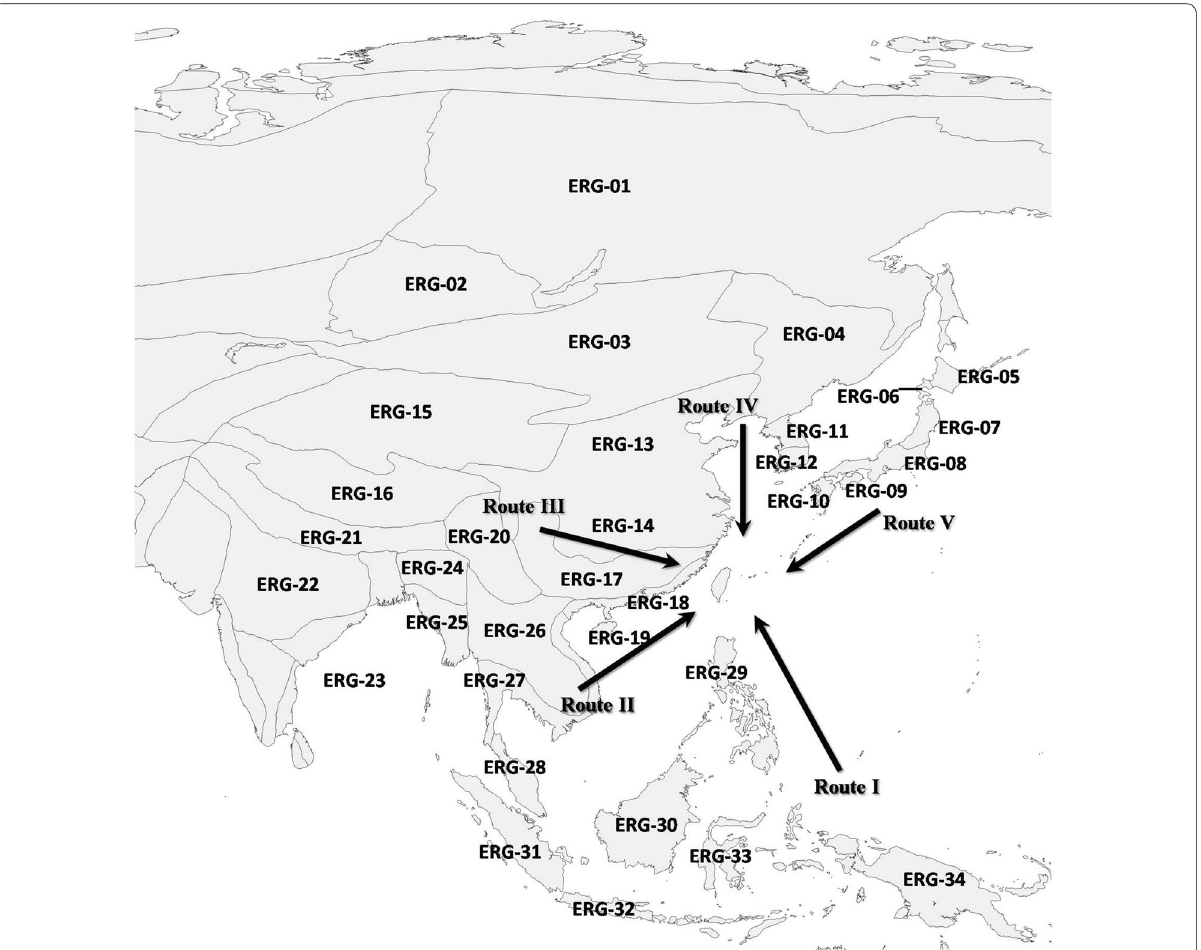
Fig. 2 Map shows the locations of 34 ecoregions in this study. The acronyms of ecoregions are the same as in Table 1. Floristic relationships among Taiwan and 34 ecoregions were analyzed in this research. The arrows show the five hypothetical migration routes of angiosperms from tropical island (Route I), tropical continent (Route II), subtropical regions (Route III), temperate regions (Route IV) and temperate islands (Route V) to Taiwan (see